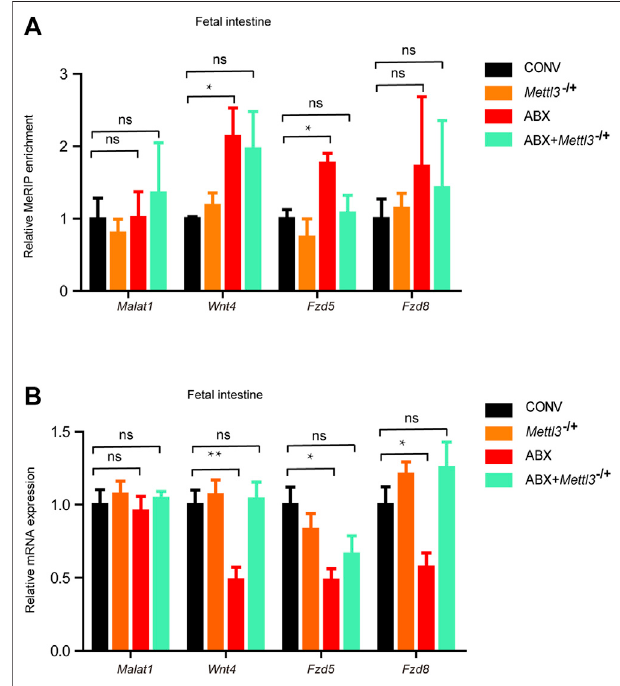
FIGURE 6 | Loss of heterozygosity of Mettl3 inhibits the susceptibility of the mouse fetal intestine to the maternal microbiome. (A) Validation of the relative m 6 A enrichments of Wnt4 , Fzd5 , and Fzd8 in the intestines of CONV, Mettl3 − /+ , ABX, and ABX + Mettl3 − /+ fetal mice by m 6 A-immunoprecipitation (IP)-qPCR. (B) Validation of the relative mRNA expression levels of Wnt4 , Fzd5 , and Fzd8 in the intestines of CONV, Mettl3 − /+ , ABX, and ABX + Mettl3 − /+ fetal